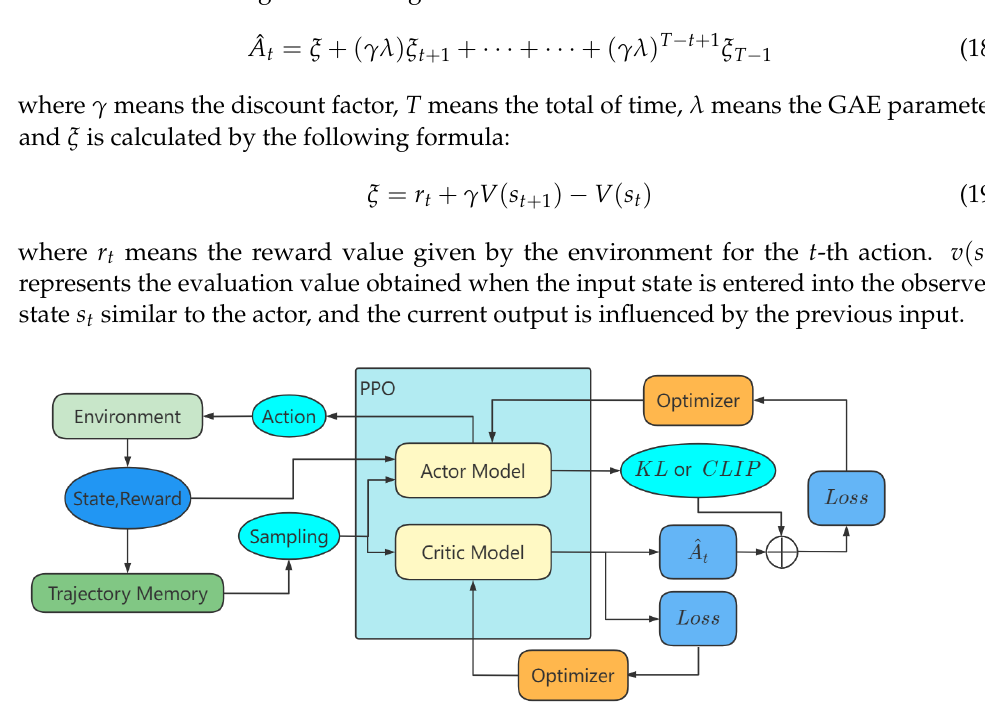
Figure 4. PPO: (I) Sampling by actor; (II) the collected data are sampled again and passed to the actor and critic; and (III) updating through the two different loss